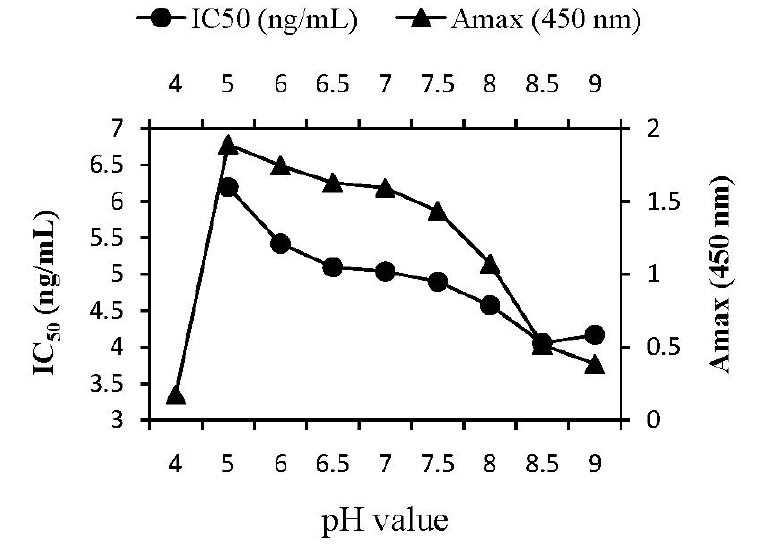
Figure 1. Effect of pH on ELISA performance. For the competition step, standards and Mab were dissolved in PB of different pH, and the G α M HRP was diluted in PB of pH 7.1. Incubation temperature was 37